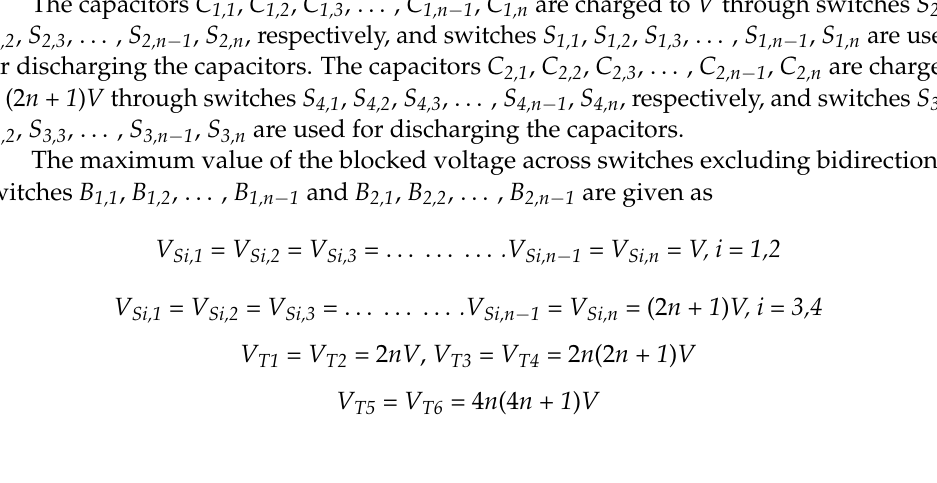
and the basic units 1st, 2nd, 3rd, . . . , n th unit connected to the right side of the modified H-bridge have an equal magnitude of DC voltage sources but different from the left side basic